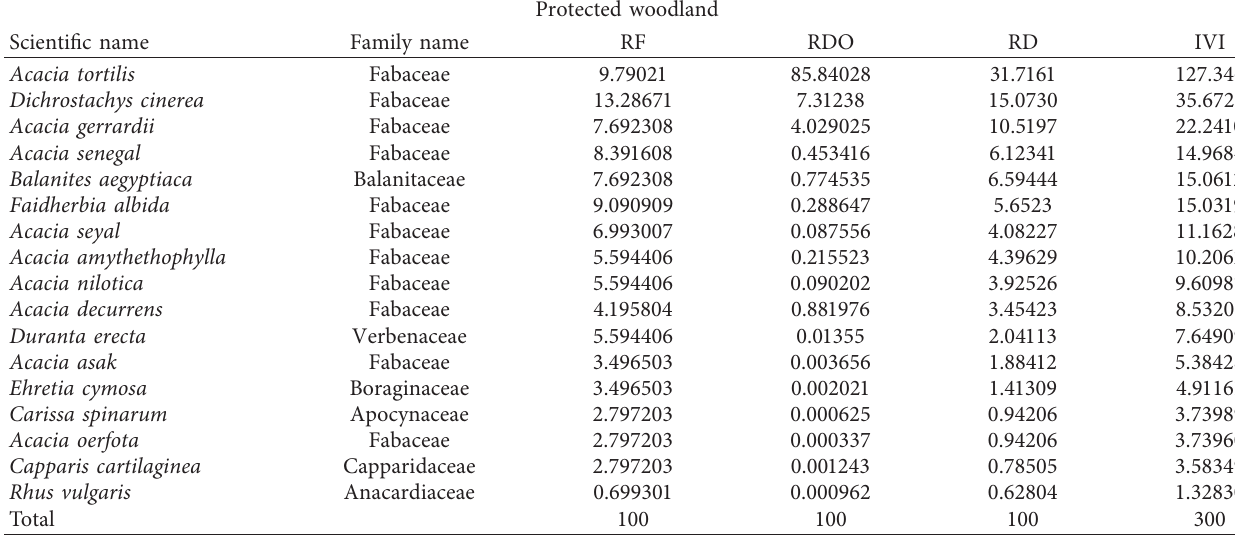
Table 5: Summary of IVI value of woody species in protected woodland in descending